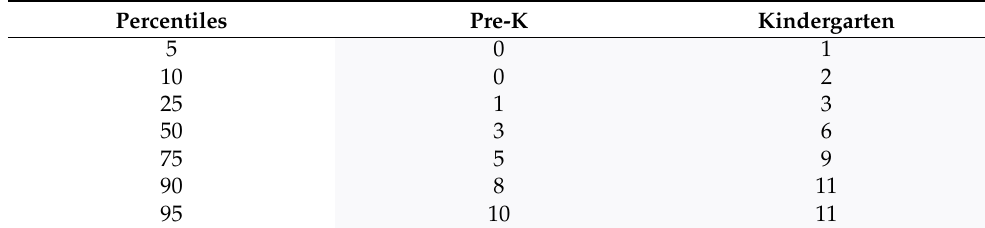
Table A2. Phonological awareness of the final syllable.